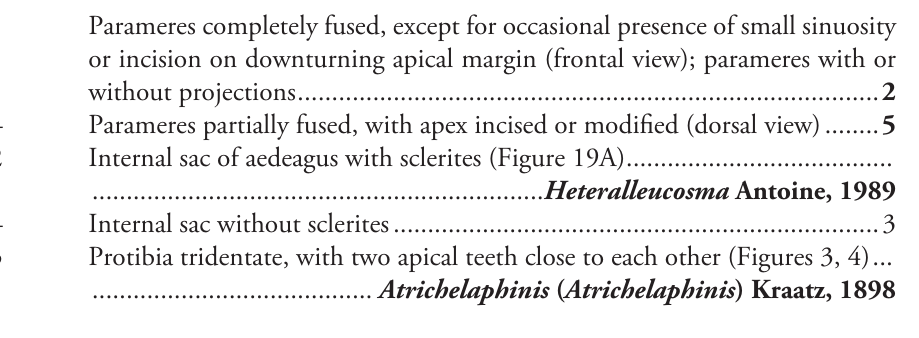
Mesosternal apophysis prominent between mesocoxae and projecting down- wards (in lateral view), lateral margins of pronotum incompletely reborded near posterior angles (Figure 16) .................. A. ( E. ) sternalis (Moser, 1914) Mesosternal apophysis not prominent between mesocoxae ....................... 10 Apicosutural angle of elytra acute and projecting backward; species of small Apicosutural angle of elytra not projecting backward; species of larger size (12 Pronotum predominantly dark-brown, with light colour and white tomentum restricted to margins; with posterior border clearly concave in front of scutellum; elytra with two large lateral light brown areas adjacent to metacoxae, basal and api- cal parts dark; parameres converging towards apex, then more abruptly near apex, apex truncate in front (Figures 8, 9) . A. ( E. ) deplanata deplanata (Moser, 1907) Pronotum light in colour, dark markings reduced but white tomentose spots more widespread; posterior margin weakly concave in front of scutellum; elytra light brown with dark markings regularly distributed; parameres al- most parallel towards apex, truncate in front forming blunt angles (Figure Elytral sculpture well developed, showing series of regularly-spaced horseshoe Elytral sculpture faint and incomplete, with intervals between punctures 13 Posterolateral angles of metacoxae from subacute to blunt; medium size species usually with metallic sheen, elytra light brown with few, small dark marks; tomentum mainly restricted laterally on pronotum and elytra (Figure – Posterolateral angles of metacoxae widely rounded; larger species without metal- lic sheen on dorsum; ground colour brown with large green patches and white tomentum scattered on entire surface (Figure 18) ......... A. ( E. ) bjornstadi sp. n.